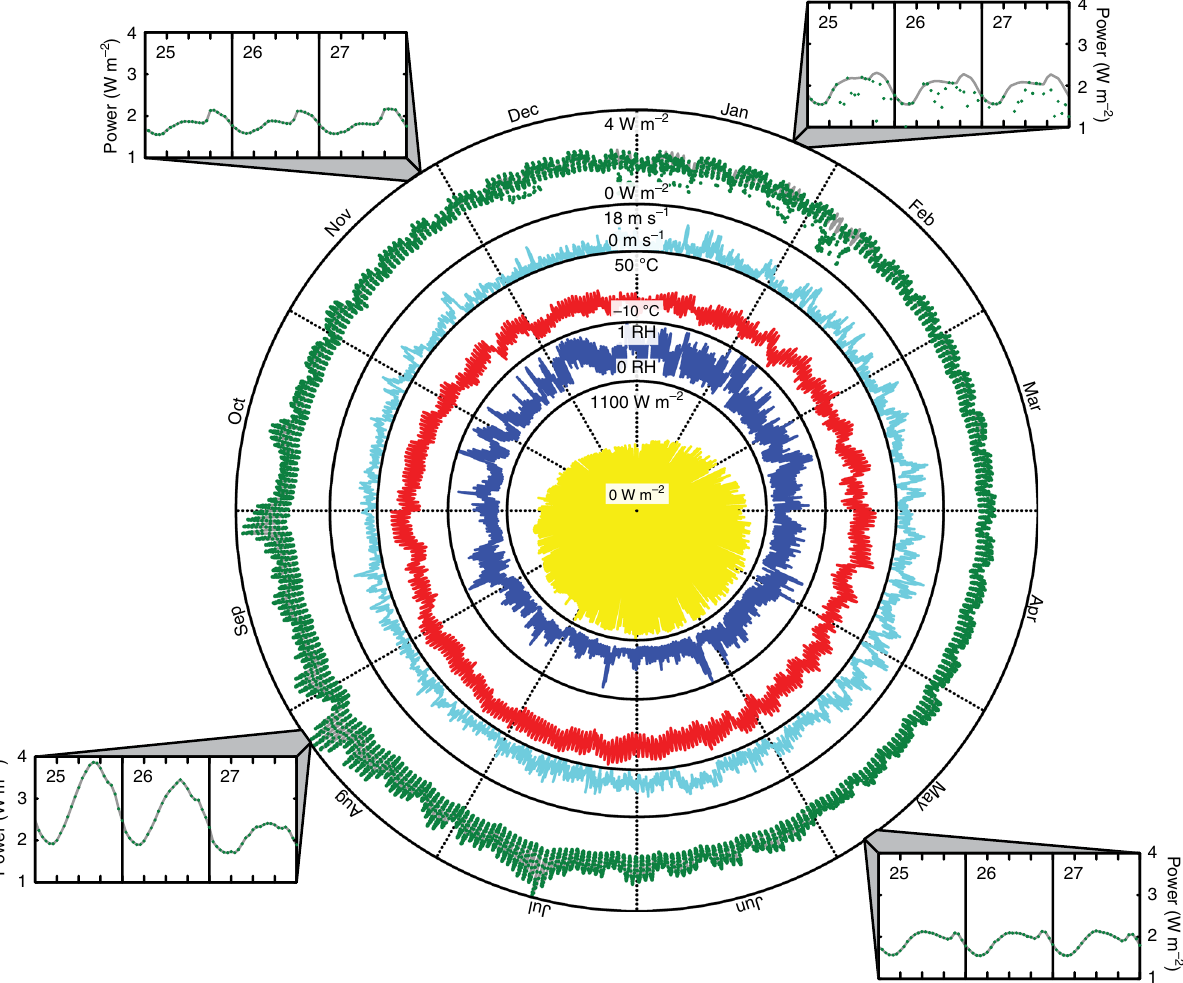
Fig. 4 Matching variable demand by controlling power output via heat storage. Results for the fi nal year of a simulation run for South-East Central California from Daggett-Barstow, California. From inside-out: Hourly (1) I ( yellow , W m − 2 ), (2) RH ( blue , %), (3) T a ( red , °C), (4) u ( cyan , m s − 1 ), (5) W PD ( gray , W m − 2 ) and predicted W O ( green dots , W m − 2 ). Clockwise from the top-right are 3-day samples of hourly W PD ( gray , W m − 2 ) and predicted W O ( green dots , W m − 2 ) for January, May, August, and November. Despite the variability of power demand and weather, power generation matches demand 95% of the time. Meteorological data 22 and power demand data 49 are from publically available databases. Annual data are evenly divided by hourly